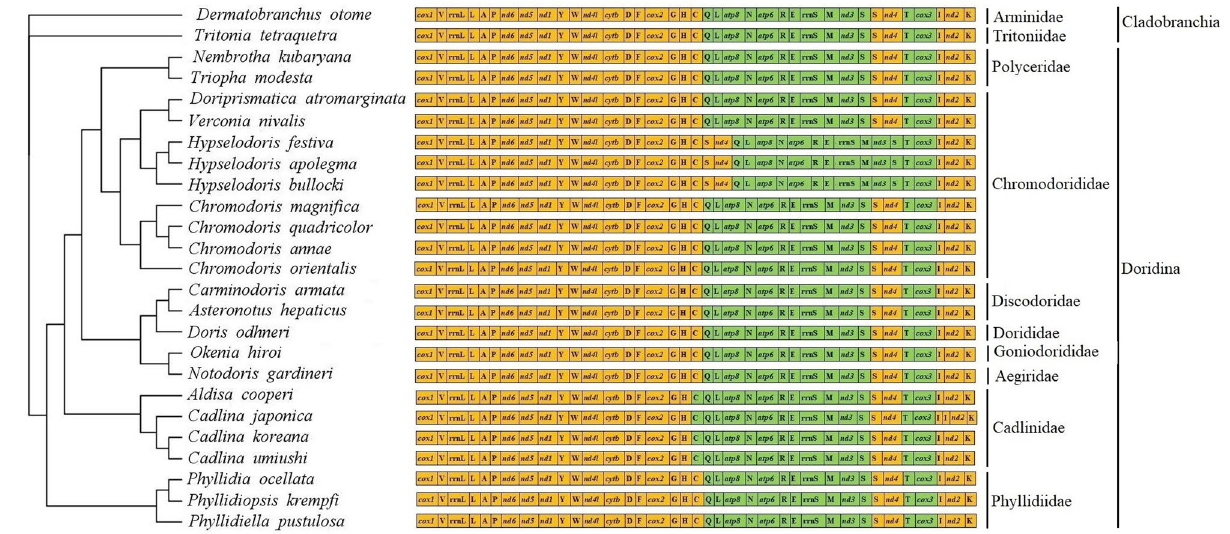
Figure 1. Linearized mitochondrial gene arrangement patterns of the suborders Doridina and Cladobranchia. Species relationships were based on phylogenetic analyses presented in Fig. 2. Yellow and green represent genes encoded on the H-strand and L-strand, respectively. Single-letter abbreviation of the amino acid code represents tRNAs.